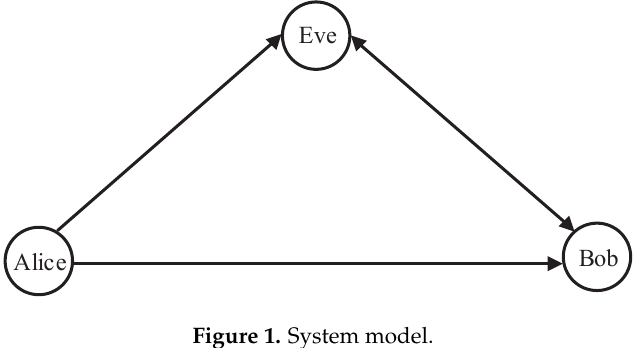
Figure 1. System